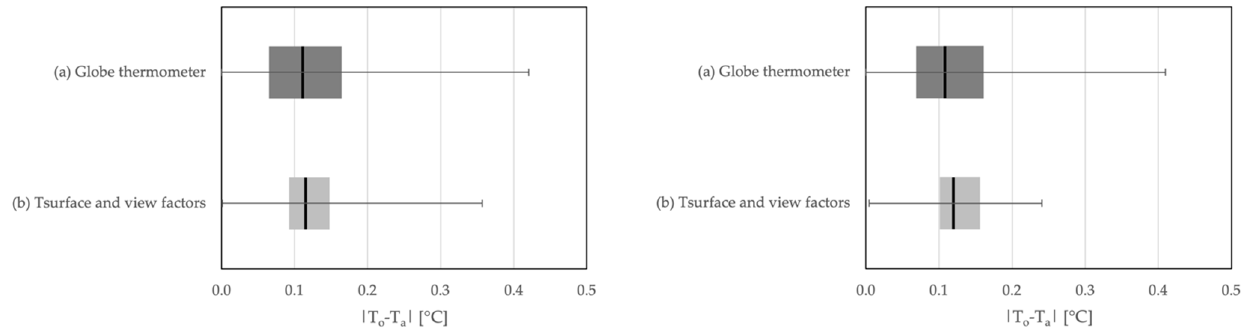
Figure 6. Absolute temperature difference | ∆ T | = (cid:12) T op − T a (cid:12) considering ( a ) the operative tempera- ture T op,g , calculated considering the mean radiant temperature obtained through the use of the globe thermometer and ( b ) the operative temperature T op,s , calculated using the mean radiant temperature calculated from measured values of the temperature of the internal surfaces of the surrounding walls, their area, and their view factor. The image on the left is referred to the entire test, the right one considers only the discharge phase. The box represents the interquartile range (i.e., 25th–75th percentiles) and the whiskers represent the minimum and the maximum.